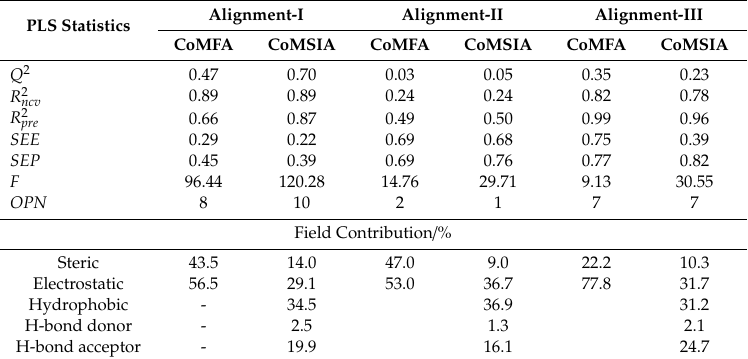
Table 1. Summary of optimal three-dimensional quantitative structure-activity relationship (3D-QSAR) results based on three di ff erent alignment methods.